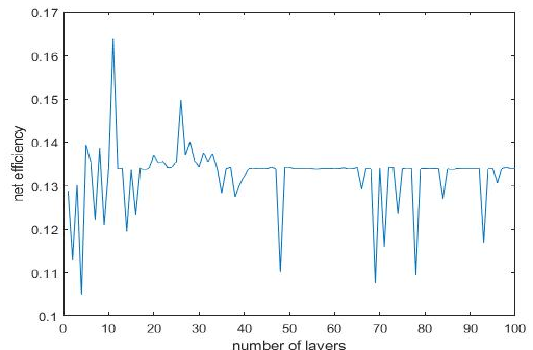
Figure 3. Efficiency of a neural network approximating y = sin ( x 1 ) + cos ( x 2 ) + 1.